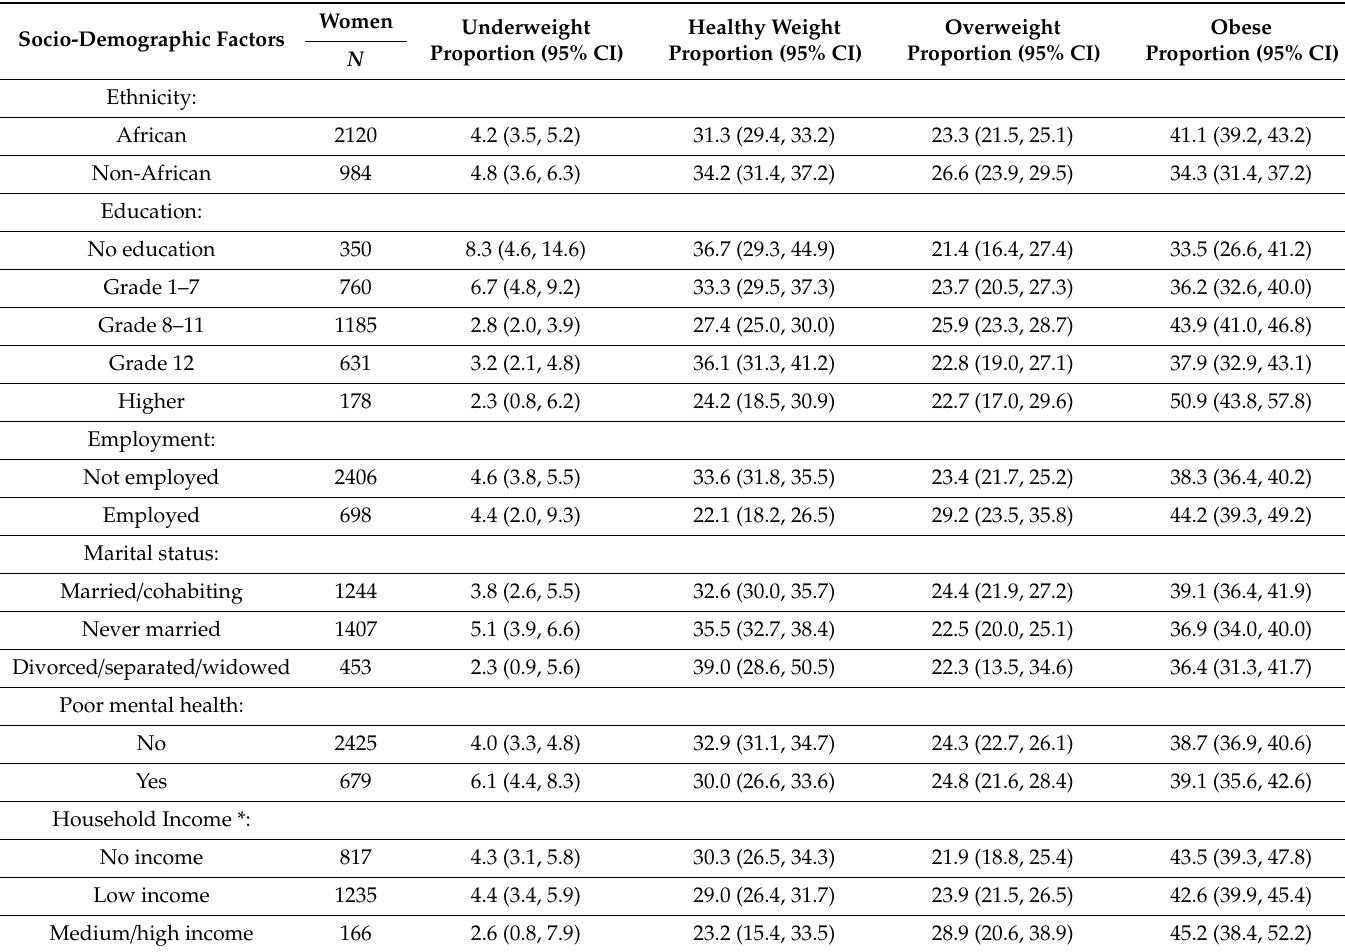
Table 3. Age adjusted proportions of underweight, healthy weight, overweight and obesity among 4170 women from the SANHANES study in 2012; by indicators of socioeconomic